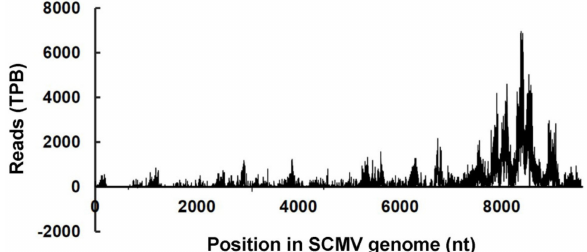
Figure 3. Distribution of vsiRNA-directed cleavage sites along the viral genome of SCMV. Reads of viral 5 (cid:48) -uncapped ends were normalized to the transcripts per billion (TPB) reads. Bars above the axis represent the cleavage sites in the sense strand of SCMV RNAs; those below represent the cleavage sites in the antisense strand of SCMV